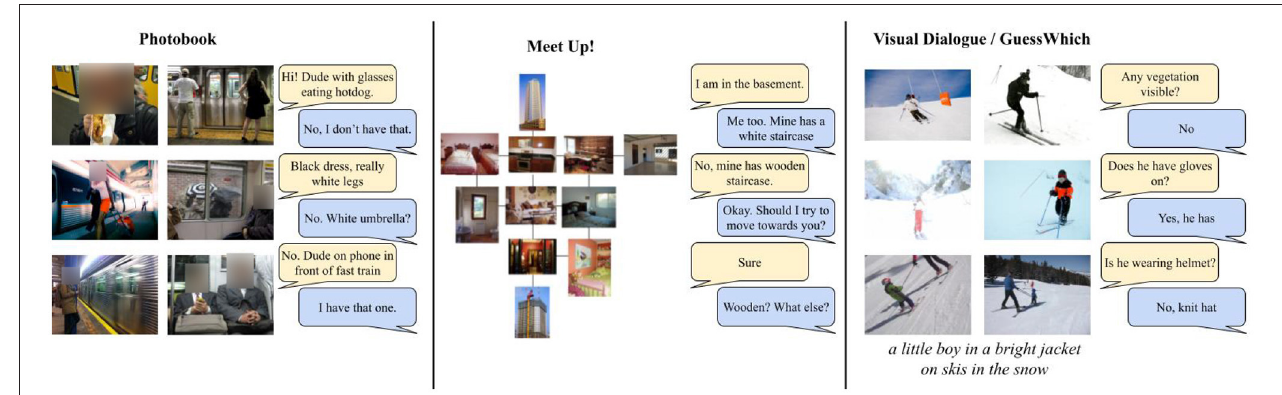
FIGURE 1 | Examples of dialogues from two asymmetric and partially observable visual dialogue data [PhotoBook and Meet Up! (Haber et al., 2019; Ilinykh et al., 2019a)] and a symmetric visual dialogue in which the answerer sees the image and the questioner does not see it (Chattopadhyay et al., 2017; Das et al., 2017). For all datasets, we selected exchanges containing negation, the focus of our